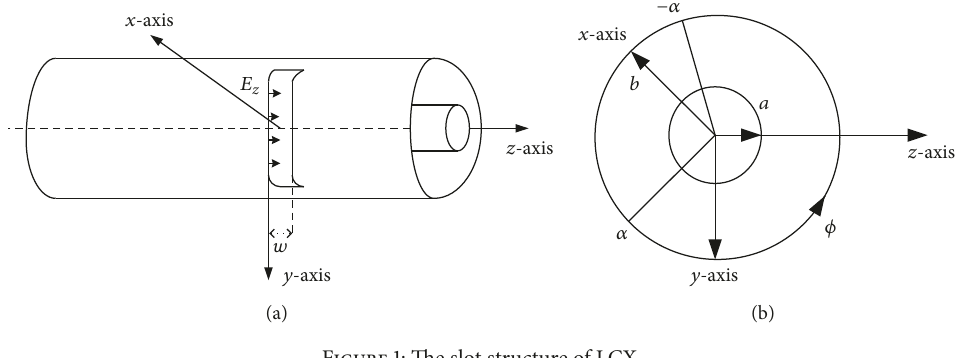
Figure 1: The slot structure of